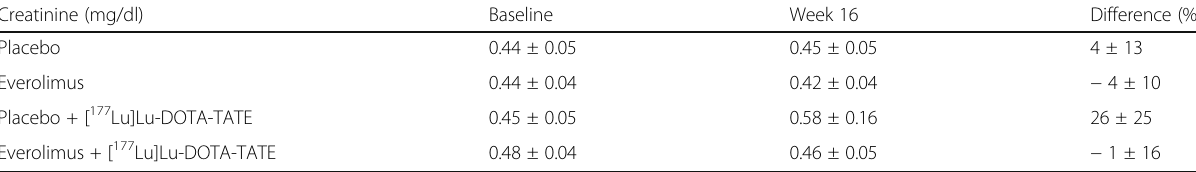
Table 3 Mean serum creatinine at baseline, week 16 and corresponding differences with confidence intervals Creatinine (mg/dl)